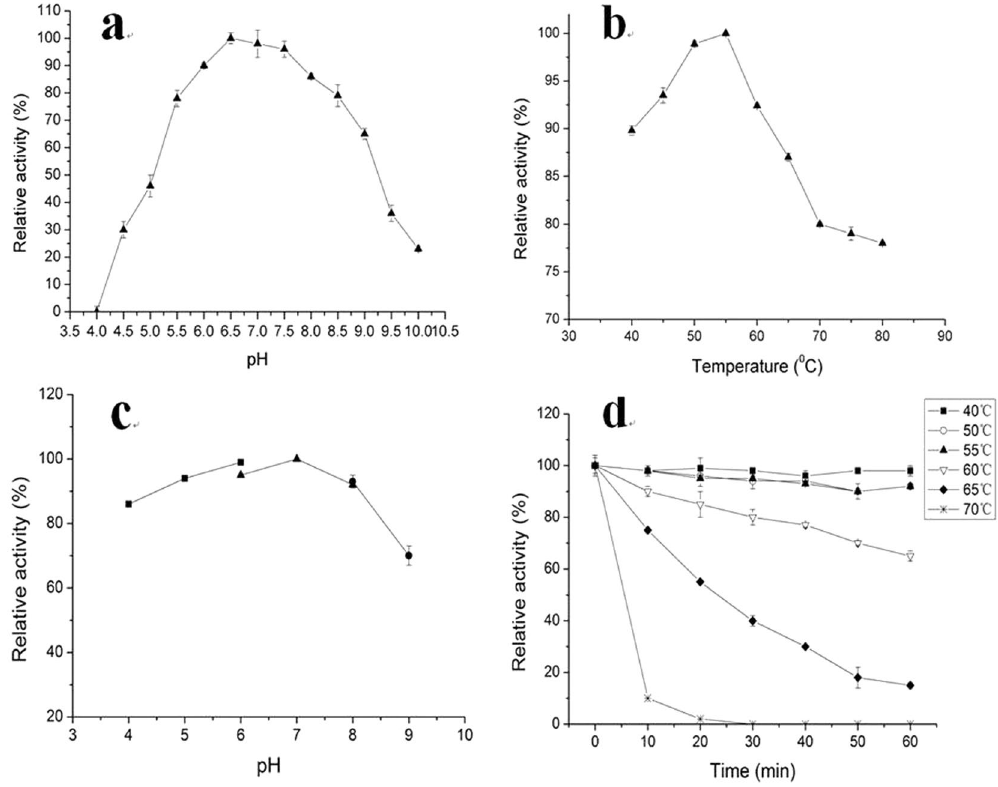
Figure 2. Effect of pH and temperature on the activity and stability of recombinant EG. ( a ) Effect of pH on activity, ( b ) Effect of temperature on activity, ( c ) pH stability, ( d ) Temperature stability. * The buffers used in the Figure 2a and c were as follows: sodium acetate buffer (pH4.0–6.0, ■ ), sodium phosphate buffer (pH 6.0–8.0, ▲ ), and Gly-NaOHbuffer (pH 9.0–10.0, ●